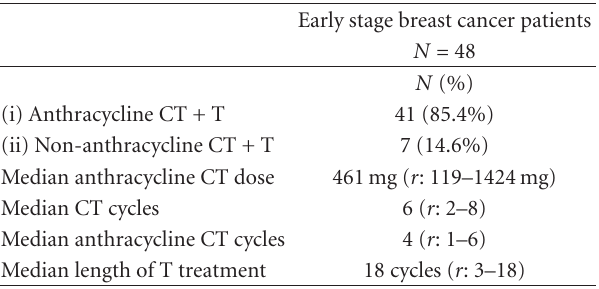
Table 4: Treatment